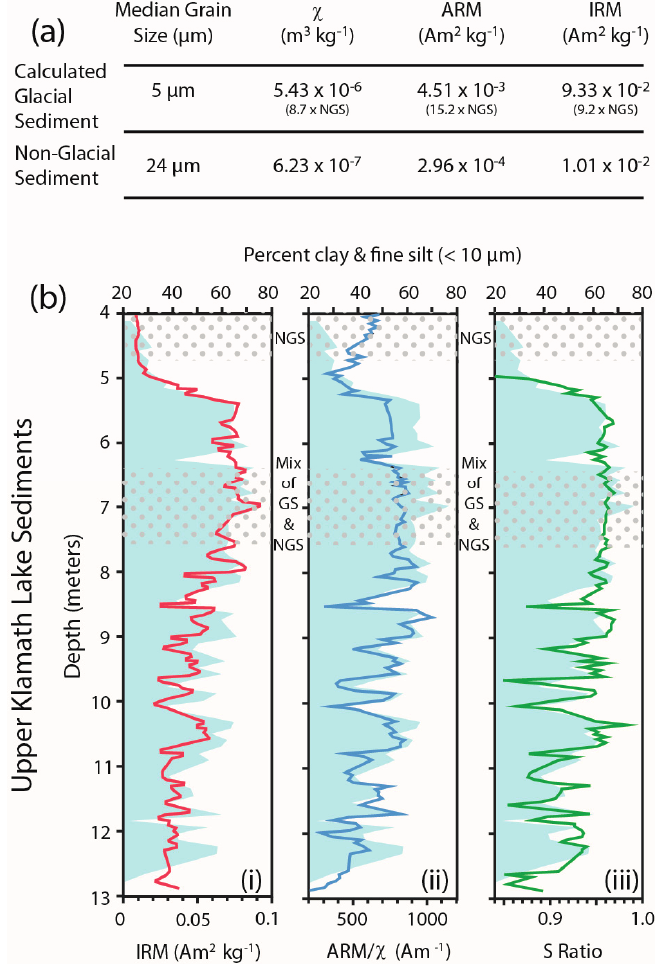
Figure 5. ( a ) Physical and magnetic properties of Upper Klamath Lake non-glacial sediment (NGS) (upper stippled zone in ( b )) and the calculated glacial sediment end member (GS) from the mixed sediment (lower stippled zone ( b )). Values in parentheses are the ratio of enrichment of magnetic properties in the GS compared to NGS, e.g., mass normalized MS ( χ ) of the GS is 8.7 times the value of the NGS. ( b ) Percent of sediment <10 μ m (light blue shading) and ( i ) IRM (red line); ( ii ) ARM/ χ (blue line); and ( iii ) S-ratios (green line) for the Upper Klamath Lake sediment core [128]. Note the strong agreement between the amount of fine sediment (linked to higher proportions of glacial sediment) and bulk magnetic properties resulting from the concentration of ferrimagnetic minerals in the GS relative to NGS ( a ) in the mixed bulk sediment. All data from Rosenbaum et al.